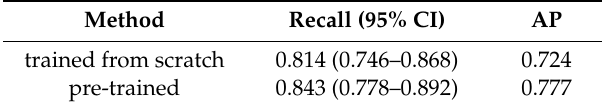
Table 6. Comparison of a pre-trained network and a network trained from scratch.